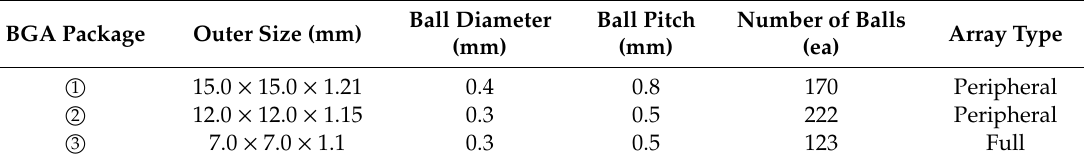
Figure 3. Test vehicle with various ball grid array (BGA) packages before and after reflow process. Table 1. BGA package specification.